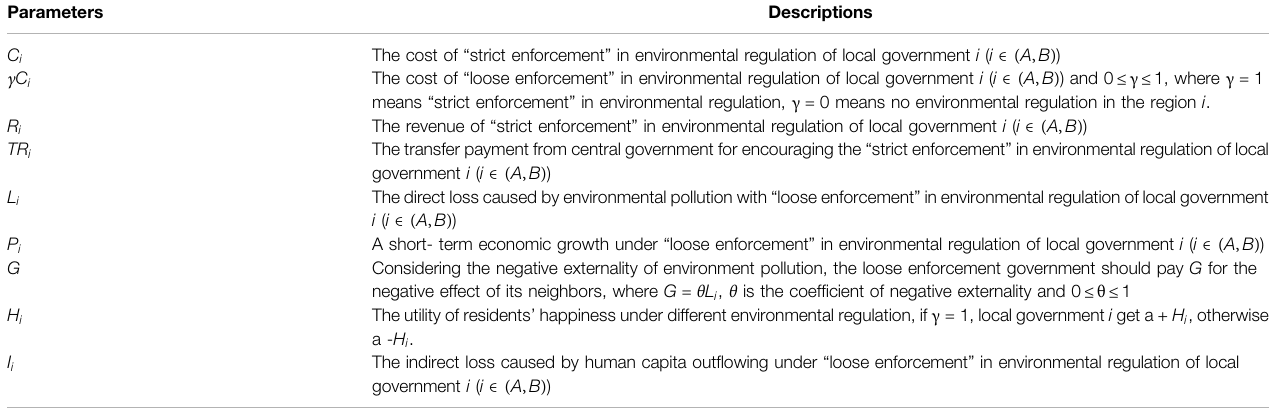
TABLE 1 | The parameters setting. Parameters Descriptions